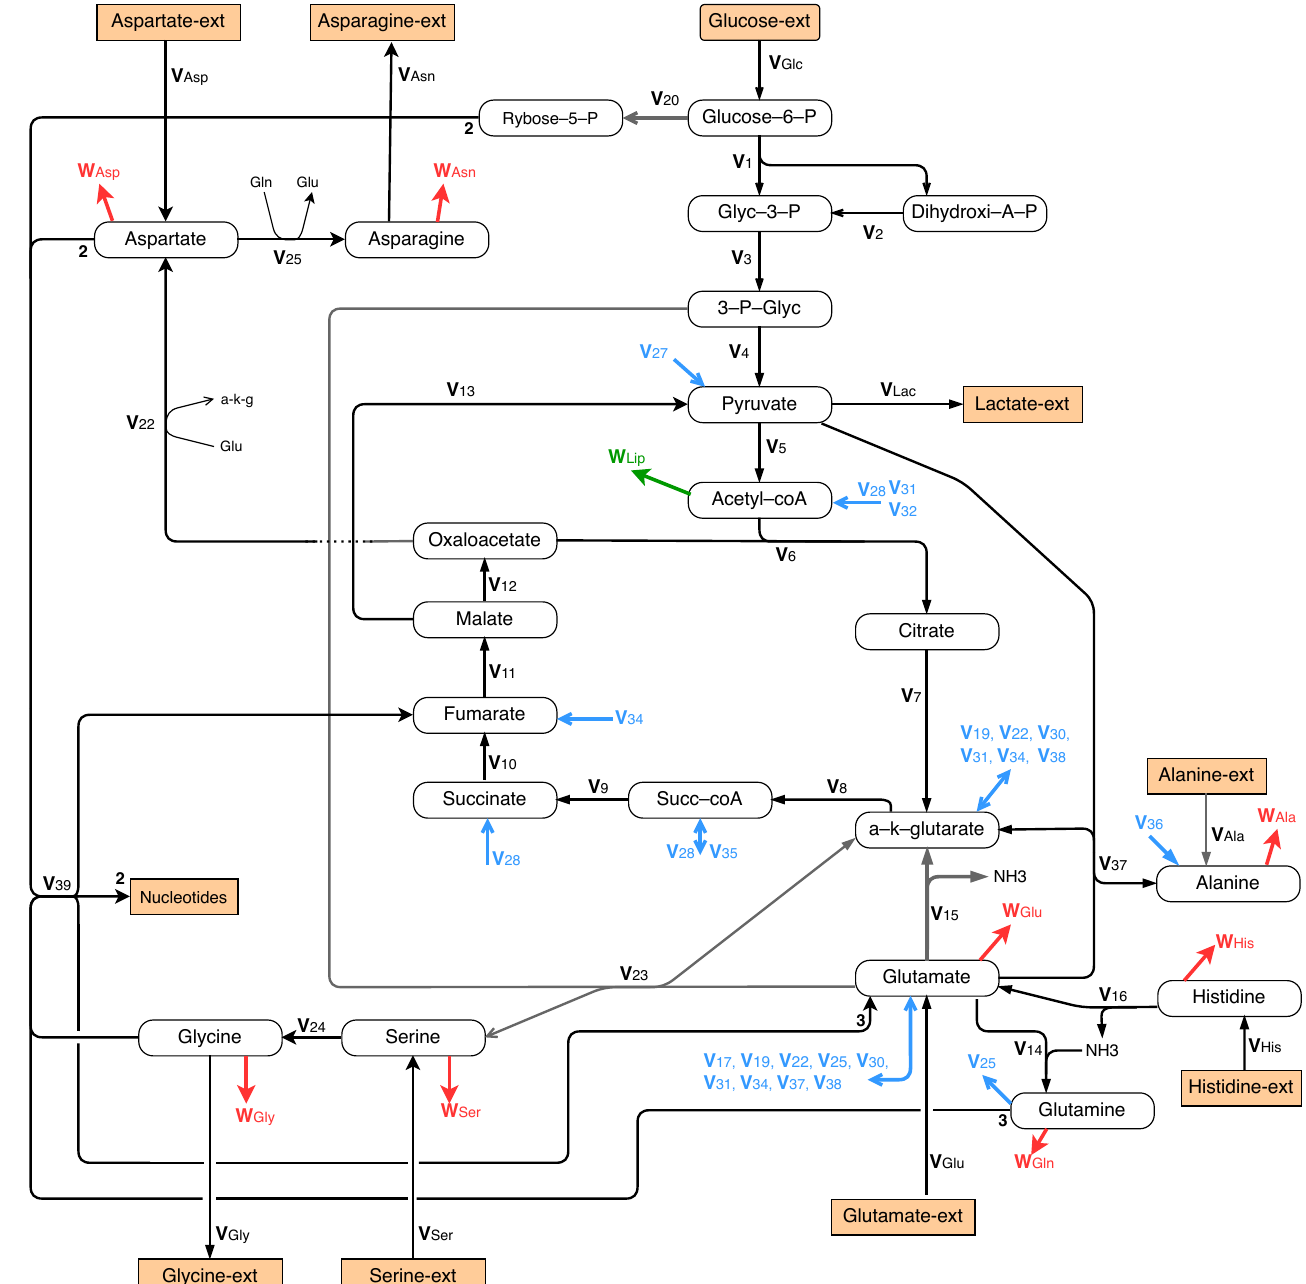
Figure 8. Growth without glutamine: central metabolism involving glycolysis, TCA and glutamine synthesis, nucleotide synthesis and metabolism of alanine, asparagine, aspartate, histidine, glycine, and